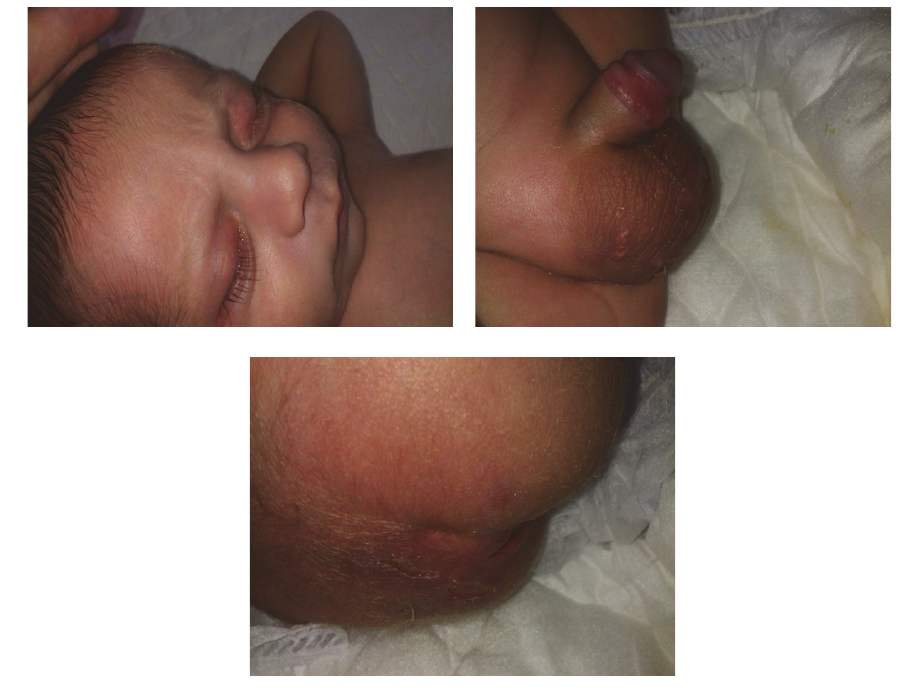
Figure 4: lesions after